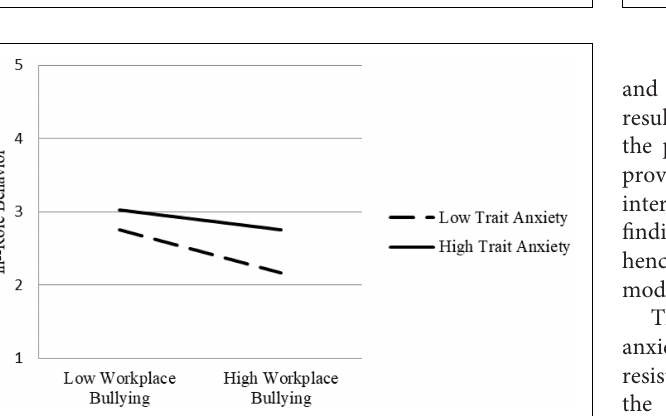
FIGURE 5 | Schematic diagram of interaction effect (workplace deviant